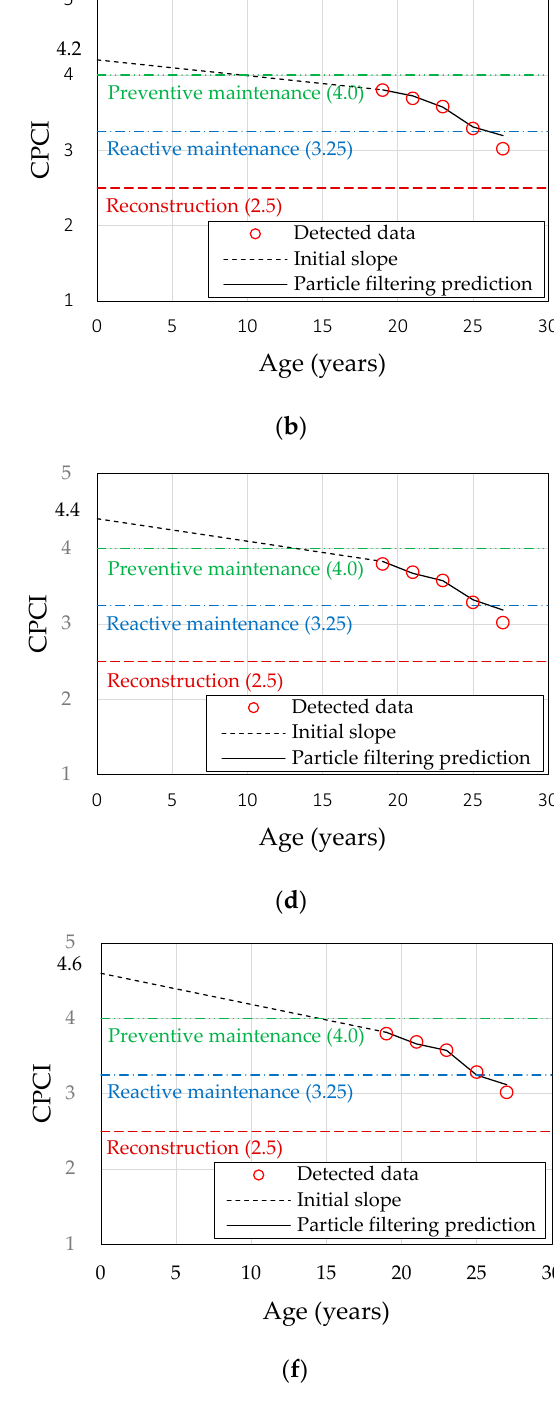
Figure 4. Comparison of detected data and particle filtering prediction. ( a ) Initial CPCI 4.2 (prediction curve using 7 points); ( b ) initial CPCI 4.2 (prediction curve using 5 points); ( c ) initial CPCI 4.4 (prediction curve using 7 points); ( d ) initial CPCI 4.4 (prediction curve using 5 points); ( e ) initial CPCI 4.6 (prediction curve using 7 points); ( f ) initial CPCI 4.6 (prediction curve using 5 points).